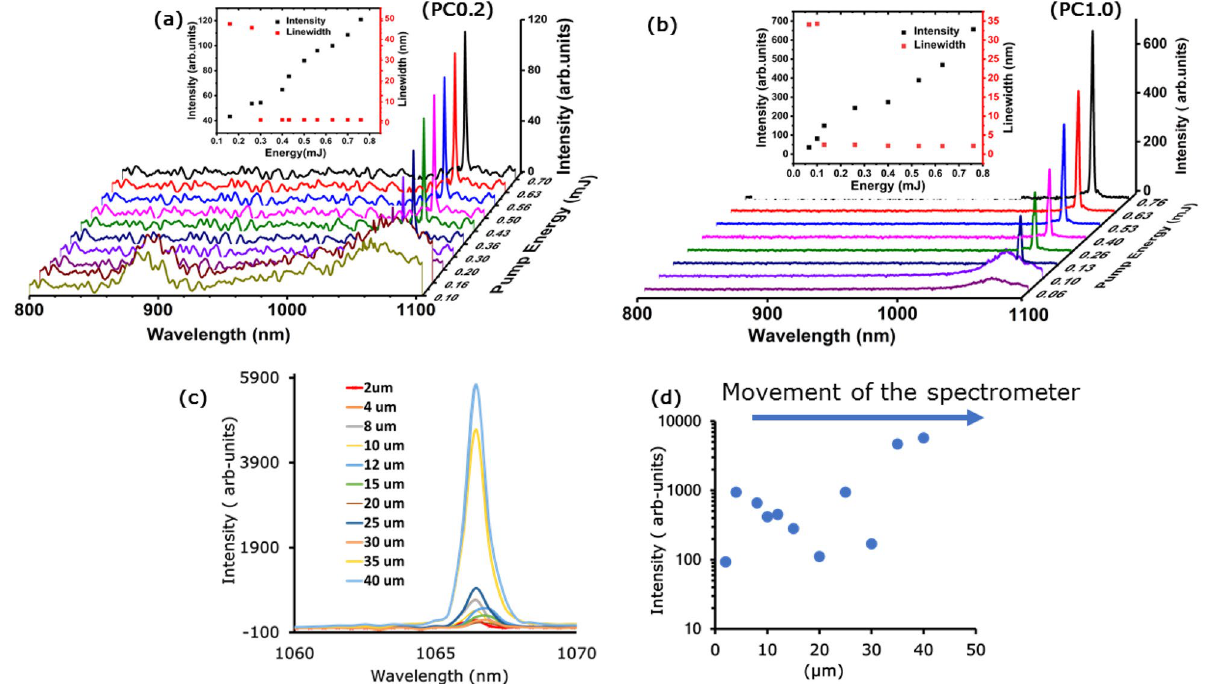
Figure 2. ( a ) The emission spectra obtained from the Nd 0.2 Y 0.8 Al 3 (BO 3 ) 4 polymer composite, and the threshold is 0.30 mJ. On further increasing the pump energy, a narrow peak emerges in the emission spectra with a linewidth of 1.31 nm. The inset shows the FWHM (red circles) and maximum emission integral intensity (black circles) vs. pump energy, ( b ) emission spectra obtained from the Nd 1.00 Al 3 (BO 3 ) 4 polymer composite, with an emission threshold of 0.13 mJ. On further increasing the pump energy, narrow peaks emerge in the emission spectra with a linewidth of 2.21 ± 0.1 nm. The inset shows the FWHM (red squares) and maximum emitted intensity (black circles) vs. pump energy. The higher noise in Figure is due to the different scaling which is normalized to the highest peak in each figure, ( c ) the lasing spectrum of PC0.8 as the spectrometer is moved in same direction (µm), which increases or decreases depending on the position of the spectrometer. The ( d ) shows the change in the laser intensity with varying position of the